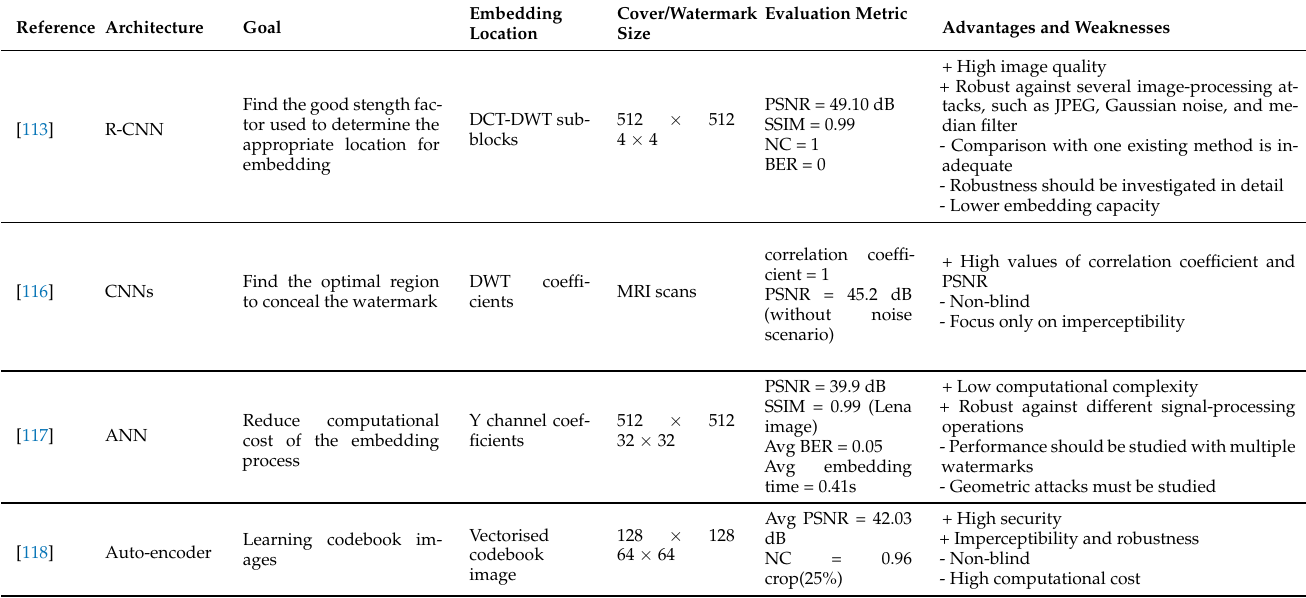
Table 4. Summary of learning-based image watermarking methods for embedding